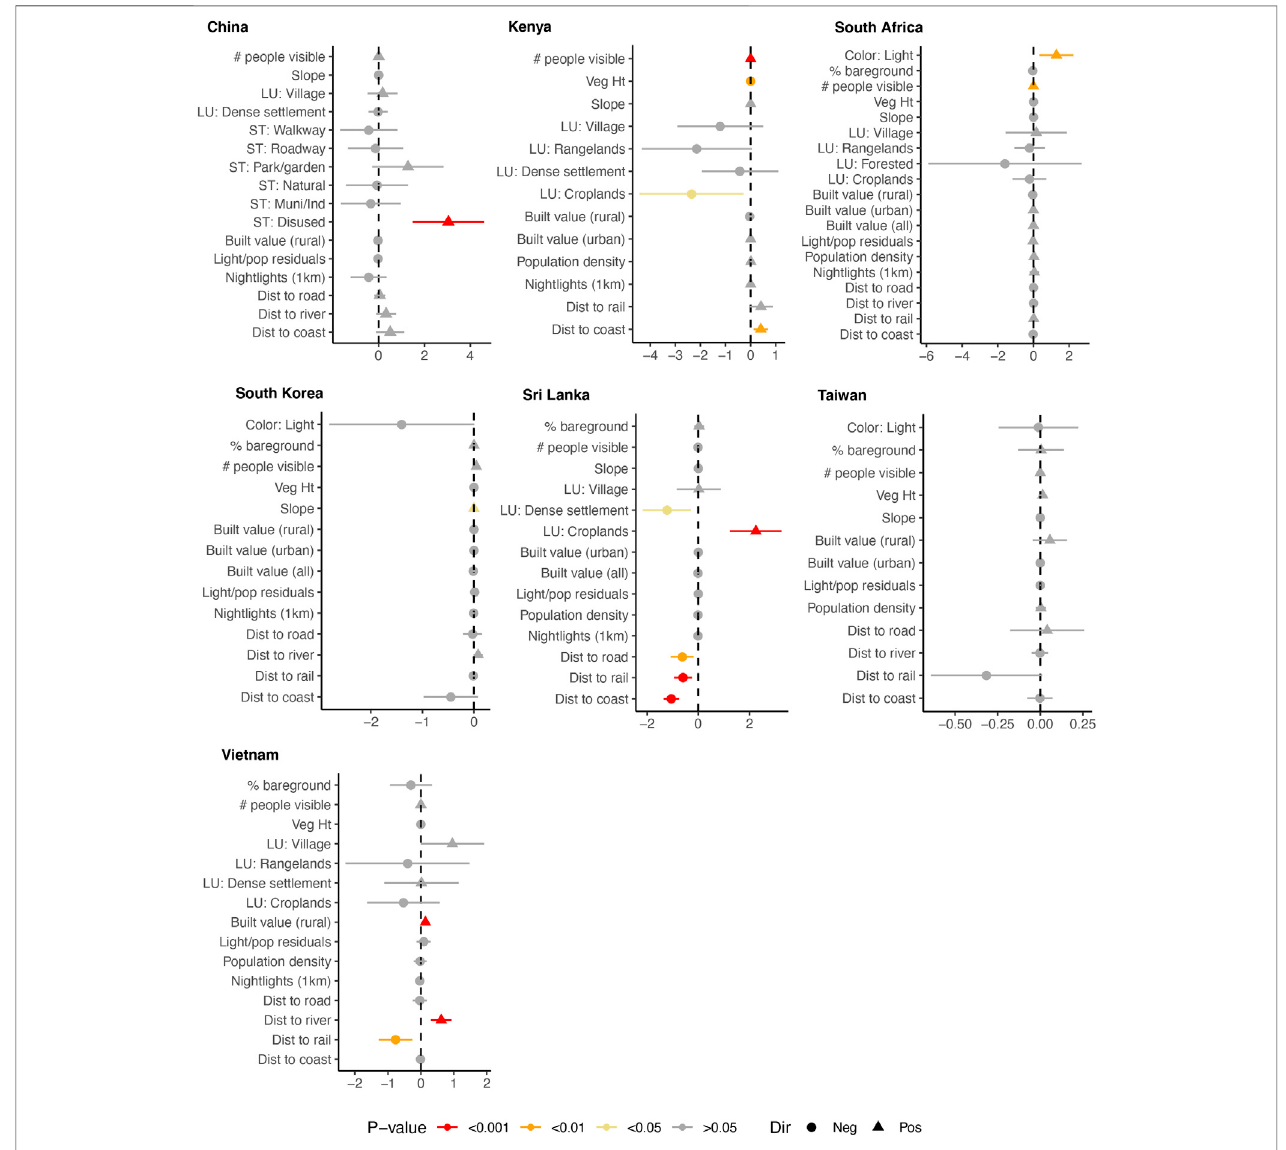
FIGURE 2 | Effect size plots for China, Kenya, South Africa, South Korea, Sri Lanka, Taiwan, and Vietnam. Color represents the p -value signi fi cance level, and the lines are the standard error for each term. Triangles denote a positive coef fi cient for a given factor, whereas circles denote a negative coef fi cient. The effect size is calculated as the median value of the factor times its coef fi